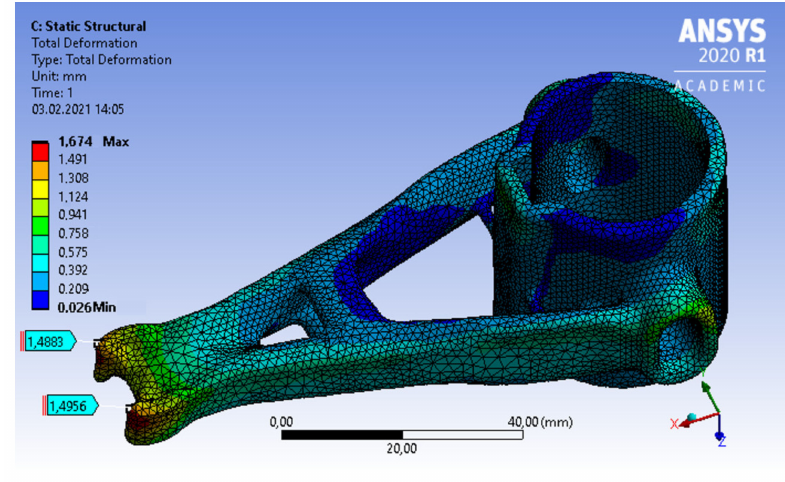
Figure 9. Stand-alone structural analysis by the ASS.